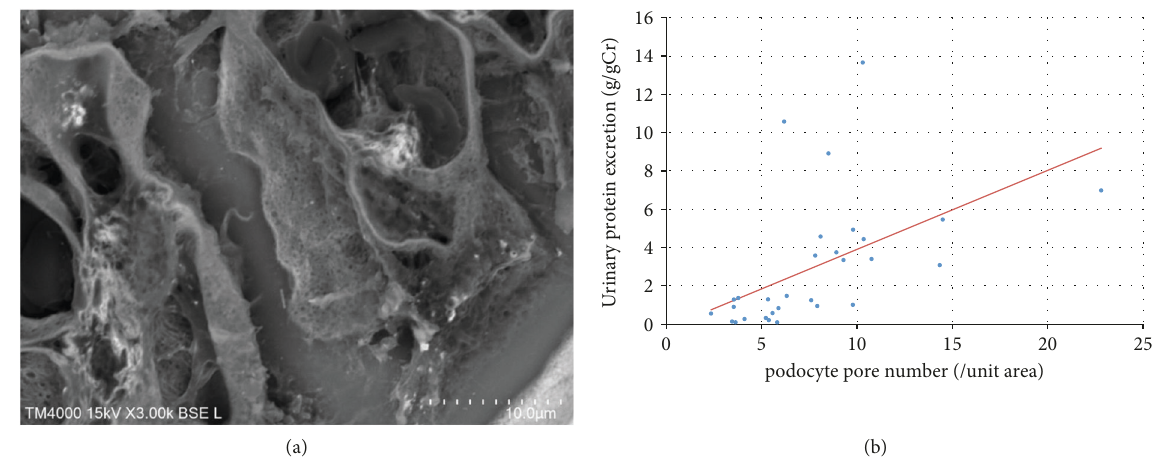
Figure 4: LVSEM observation of podocyte surface pores (a) and the correlation between podocyte pore number and urinary Table 2: Correlation of clinical parameters with urinary podocytes. Urinary podocyte (/HPF)